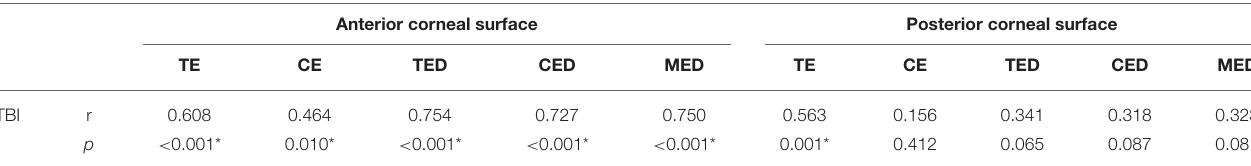
TABLE 6 | Correlation of corneal elevation parameters with TBI in AC patients. Anterior corneal